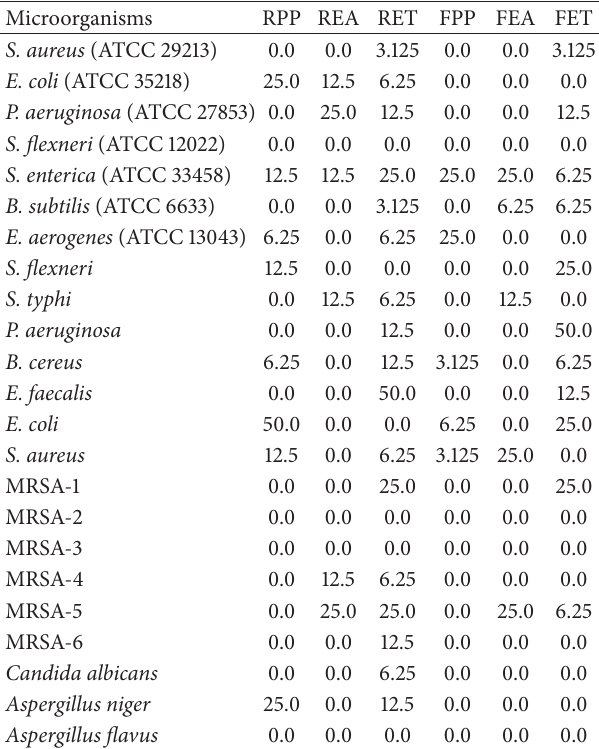
Table 6: Minimum bactericidal concentration (MBC) of Lenzites quercina extracts (mg/mL) against tested